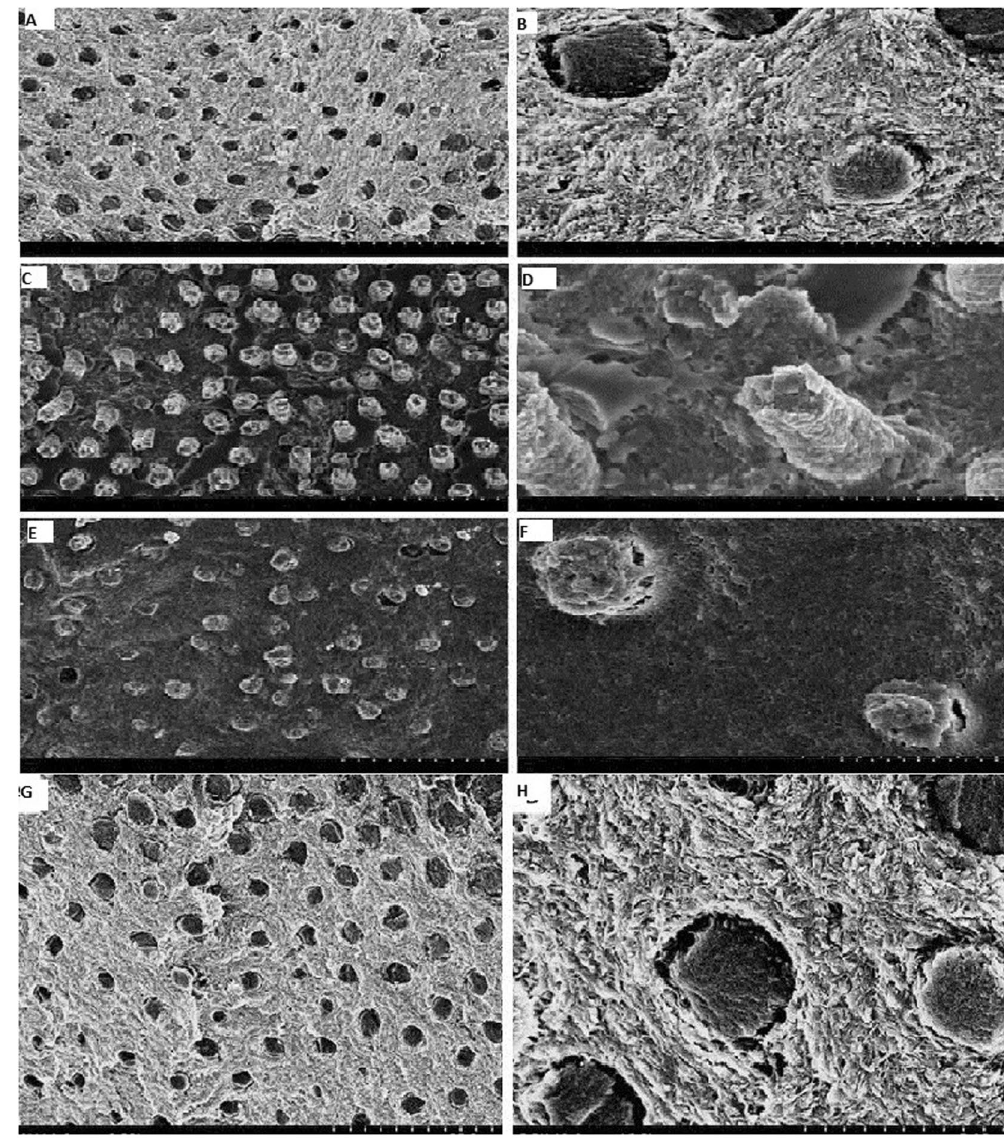
Figure 3. Cross Sectional Images of the after the Resin Treatment groups and Failure interfaces. ( A ) COR images: Binder adopts at the bottom surface of DHL homogeneously. ( B ) Amplification of COR images: Clear evident fracture walls between the resin and tubular wall, very short tabular walls evident with no exposure to collagen. ( C ) CHR images: Binder completely adopts the DHL and fantastic resin infiltration into the tubules of dentin. ( D ) Amplification of CHR images: Resin seems to be very much dense and much longer with no collagen exposure, no fractured walls. ( E ) DOR images: homogeneous binder coverage, most of the tubes have resin infiltration. ( F ) Amplification of DOR images: resin is thick and within tubules, with small cracks between the resin and tube wall, no exposed collagen fiber can be seen. ( G ) PAR images: Binder adopts at the bottom surface of DHL homogeneously. ( H ) Amplification of PAR images: Evident fracture walls between the resin and tubular wall, very short tabular walls evident with no exposure to